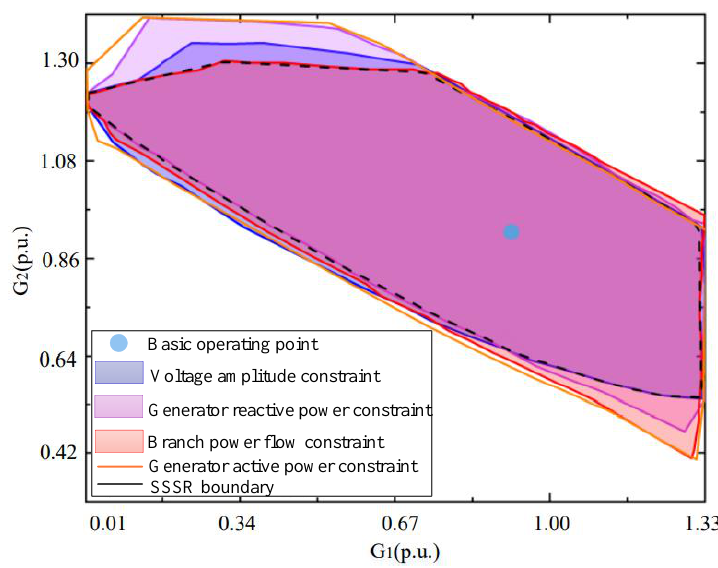
Figure 6. Two-dimensional SSR constructed by IPSO-RLS hybrid algorithm. For parameter identification, take synchronous unit G 89, wind turbine DFIG ( G DFIG 25), and the PV unit ( G PV 59) of IEEE 118 bus system as examples to obtain the three-dimensional SSSR, as shown in Figures 7–9.